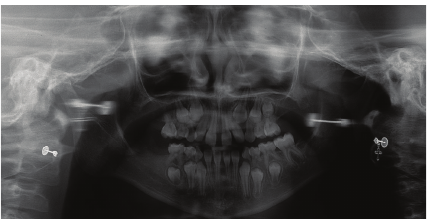
Figure 2: Panoramic radiograph demonstrating absence of